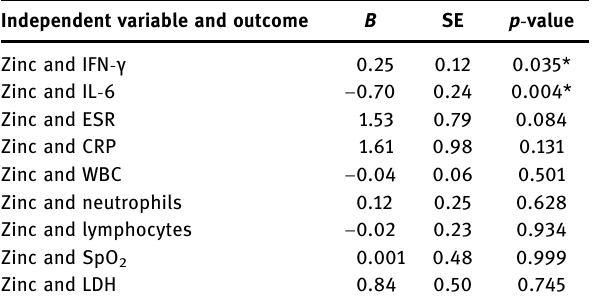
Table 2: Association between zinc and in fl ammatory factors Independent variable and